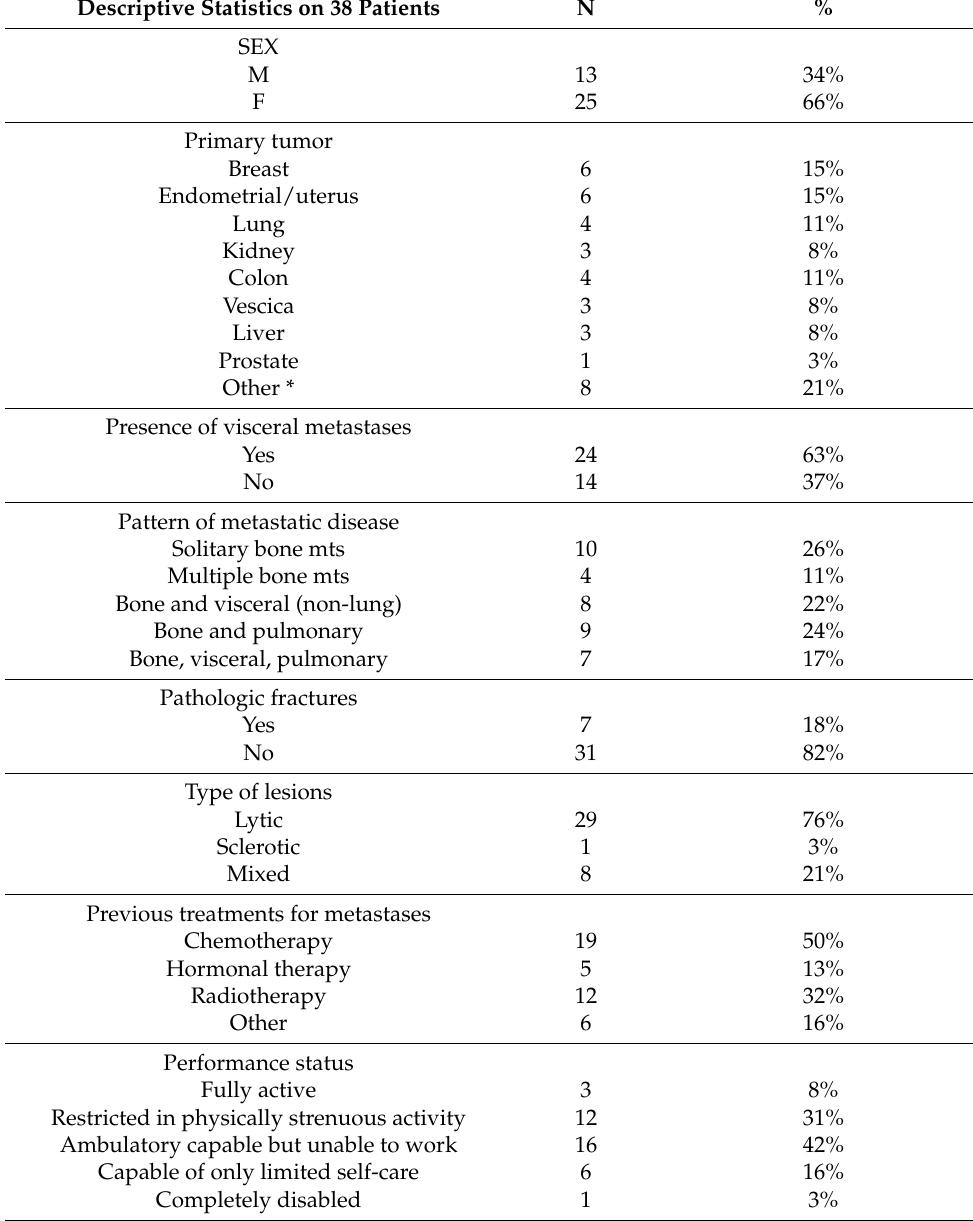
Table 1. Descriptive statistic of the population. Descriptive Statistics on 38